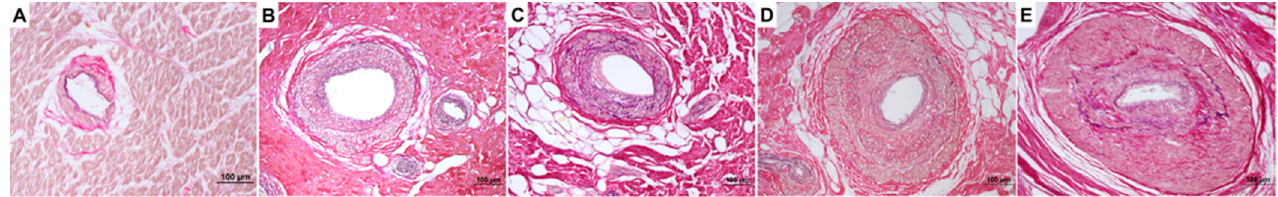
Figure 1. Score of small vessel disease based upon luminal narrowing (( A ), 0, no abnormality; ( B ), 1+, luminal stenosis <20%; ( C ), 2+, luminal stenosis 20–50%; ( D ), 3+, luminal stenosis >50–90%; ( E ), 4+, luminal stenosis >90%). (( A – E ), Weigert van Gieson).